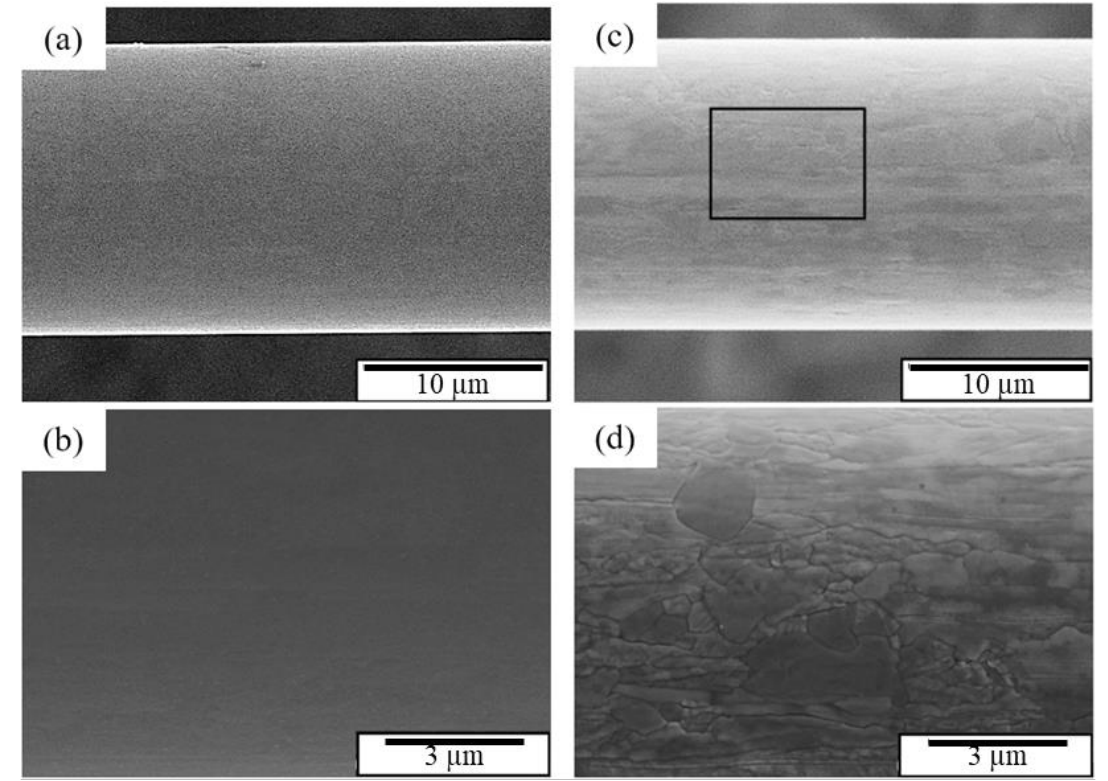
Figure 3. Surface morphology of the APAP wire: ( a ) macroscopic image before chlorination, ( b ) local magnified image before chlorination, ( c ) macroscopic image after chlorination for 4 h, and ( d ) local magnified image after chlorination for 4 h.